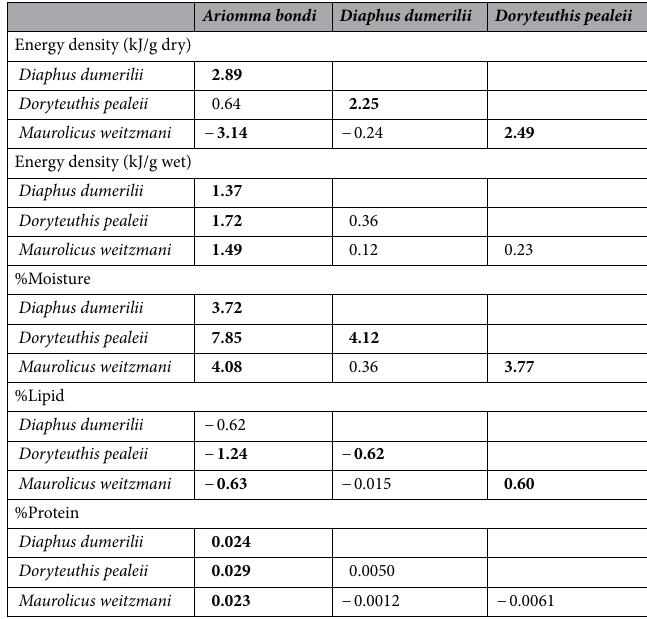
Table 4. Tukey’s pairwise comparisons between proximate composition measures of Rice’s whale ( Balaenoptera ricei ) prey. Bold indicates a significant difference (p < 0.05).